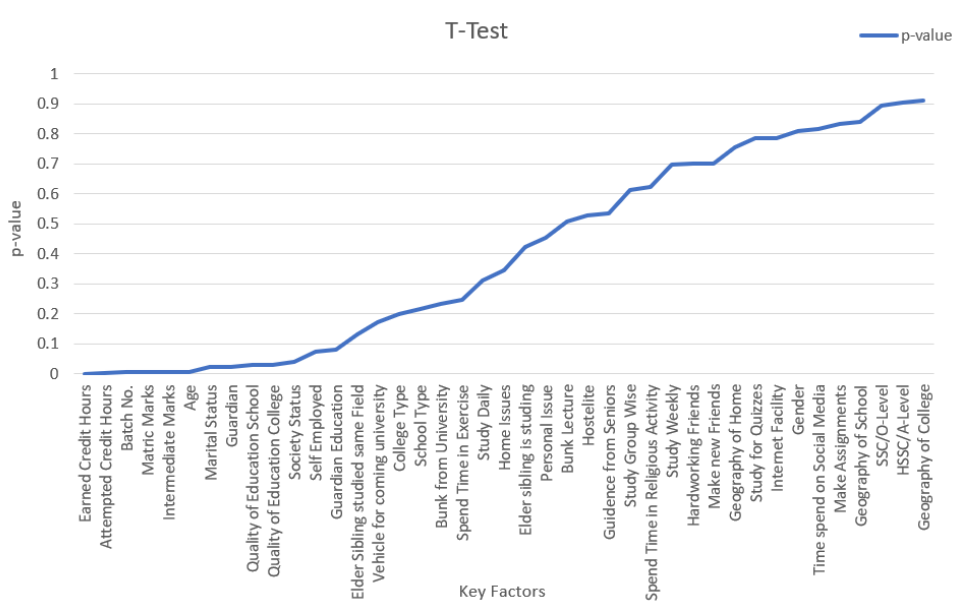
Figure 16. T-Test ( p